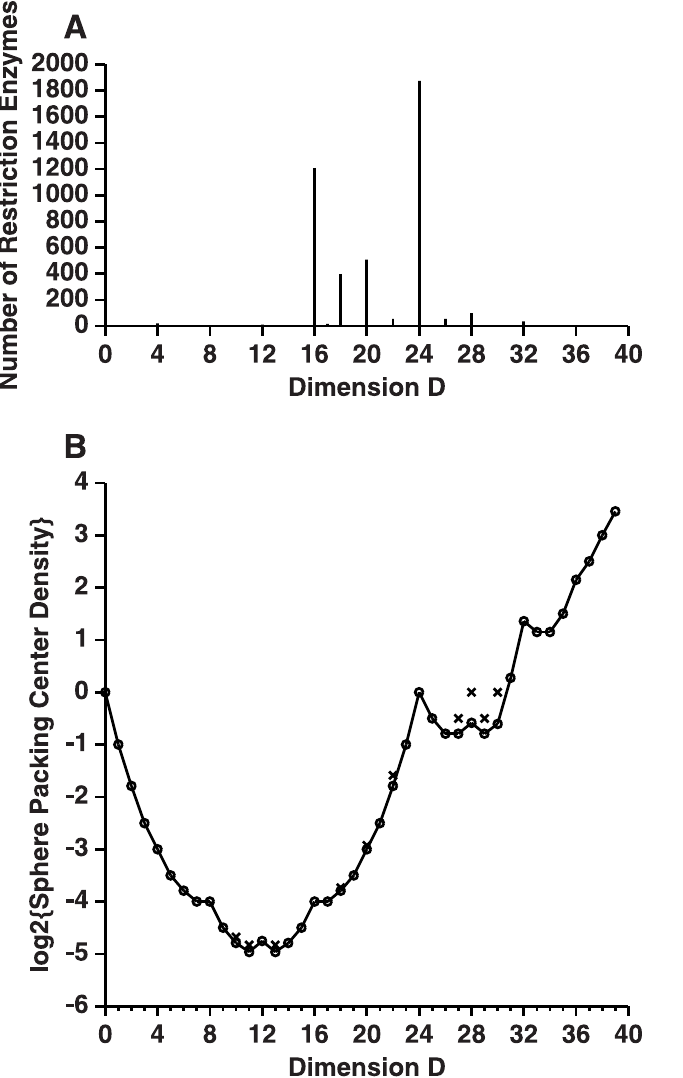
Fig 3. Comparison of restriction enzyme frequency and best known sphere packing density in different dimensions. A. Coding dimensions used by restriction enzymes. The number of enzymes at each dimensionality is plotted from Table 1. B. Best known sphere packings in high dimensions were given by Conway and Sloane [26, 44]. The graph is equivalent to their Figure 1.5; see Table I.1(a), Table I.1(b) on pages xix and xx; and pages 14 to 16. The updated sphere center density formulas used here were from http://www.math.rwth-aachen.de/~Gabriele.Nebe/ LATTICES/density.html (Last modified Feb. 2012, accessed Jan 06, 2018). The sphere center density, δ , is the number of sphere centers per unit volume when sphere radii are set to 1. Without the logarithm, a graph of δ versus D appears nearly flat from D = 7 to D = 18. Circles (˚) represent lattice packings; x’s ( × ) represent nonlattice packings.